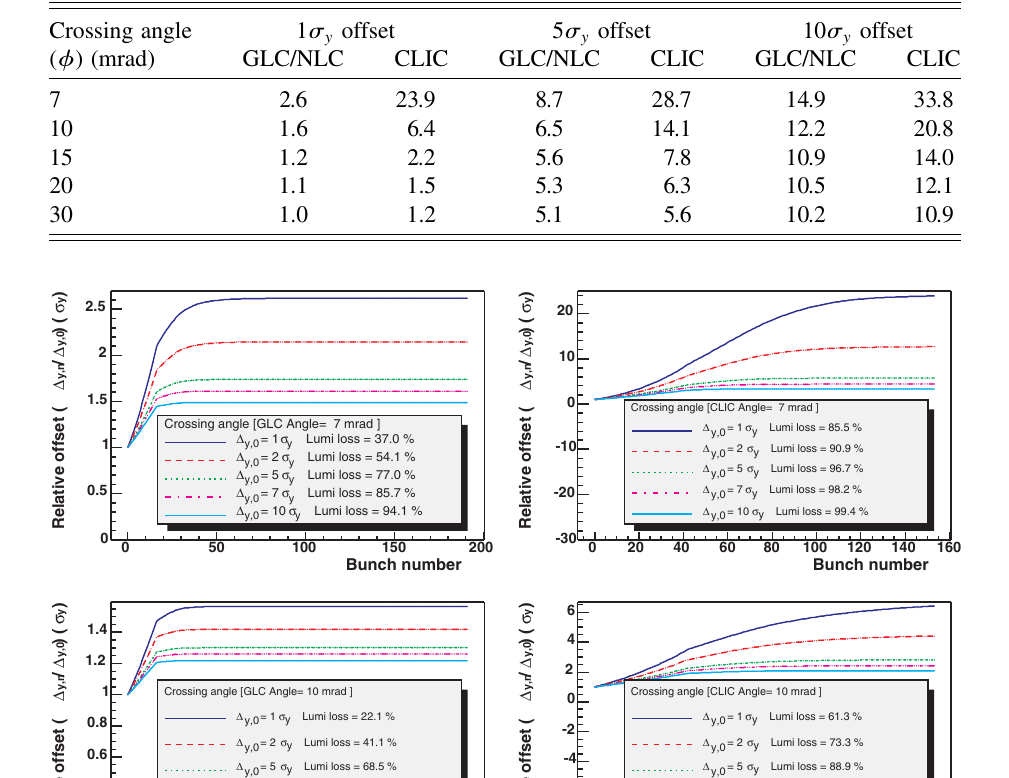
TABLE II. Vertical offset (expressed in beam size (cid:1) crossing angles (the other parameters have the values mentioned in Table I).